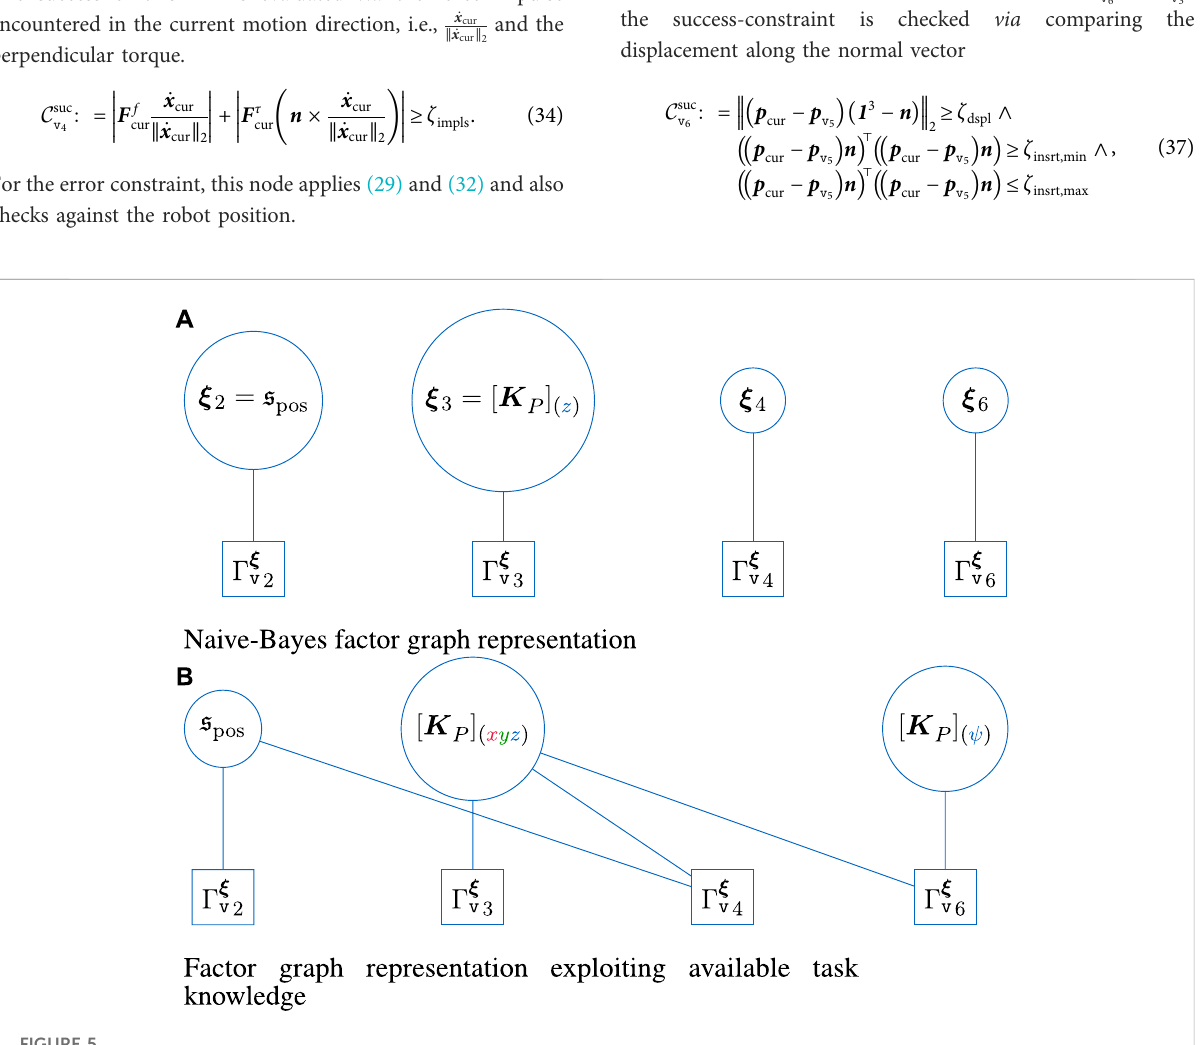
FIGURE 5 Representation of thesuccess probability of the unscrewing skill as factor graphs. Here, thenaive Bayes approachis also highlightedas a factor graph, while the actual factor graph exploits available task knowledge to introduced conditional dependence and independence in the regression problem that allows adding samples ef fi ciently during